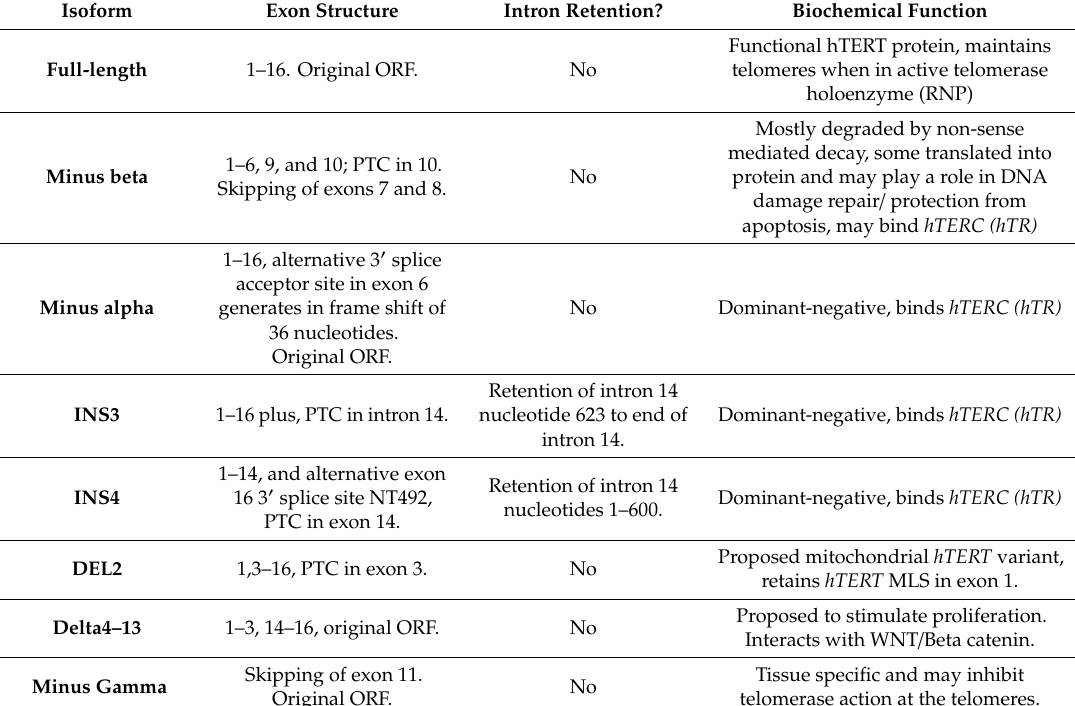
Table 1. Description of major hTERT splice